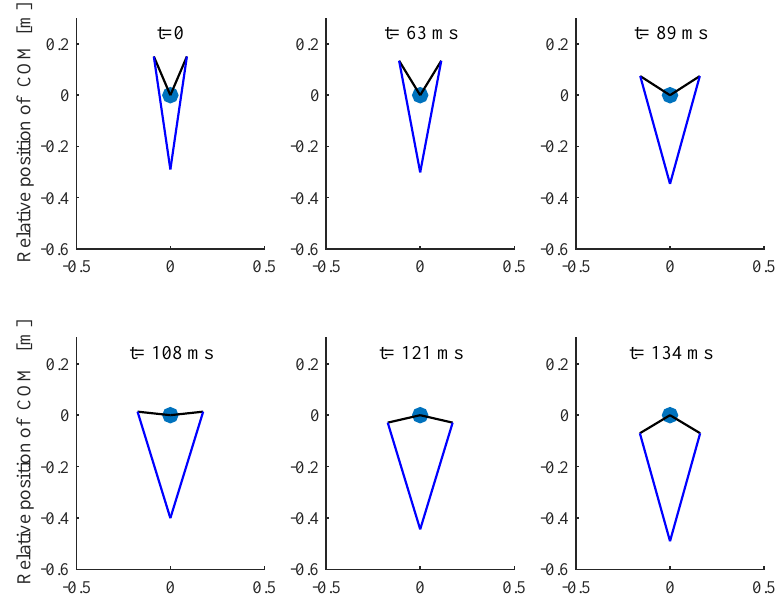
Figure 8. The simulation of vertical